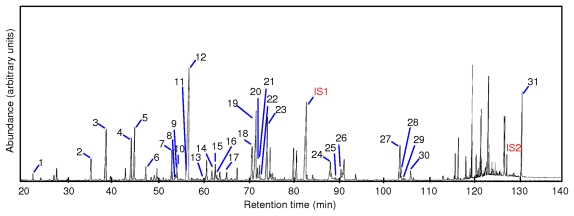
GC-MS chromatograms of PLFA and PLEL extracted from anaerobically digested sludge under optimal scCO2 extraction conditions. The numbers near the peaks are as follows: (1) 12:0, (2) i14:0, (3) 14:0, (4) i15:0, (5) a15:0, (6) 15:0, (7) i16:0, (8) 16:1ω9c, (9) 16:1ω8c, (10) 16:1ω7c, (11) 16:1ω5c, (12) 16:0, (13) 10Me16:0, (14) i17:0, (15) a17:0, (16) cy17:0, (17) 17:0, (18) 18:2, (19) 18:1ω9c, (20) 18:1ω7c, (21) 18:1ω9t, (22) 18:1ω8c, (23) 18:0, (IS1) the internal standard nonadecanoic acid methyl ester, 19:0, (24) 20:1ω9c, (25) 20:1ω9t (26) 20:0 (27) 22:1ω9c, (28) 22:1ω9t, (29) 22:1ω7c, (30) 22:0, (IS2) the internal standard 1,2-di-O-hexadecyl-rac-glycerol, and (31) diether(DE)-lipid.